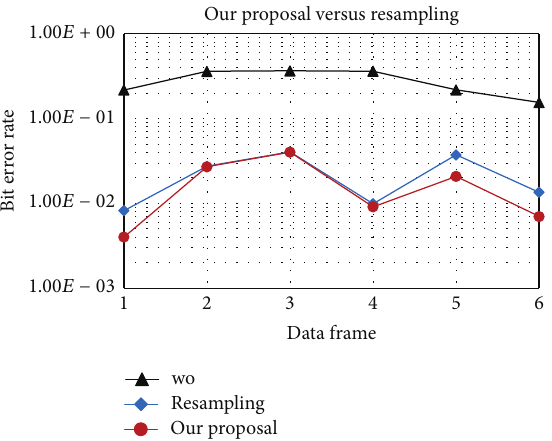
Figure 16: 64QAM, BER of proposed method versus the resampling based method in the